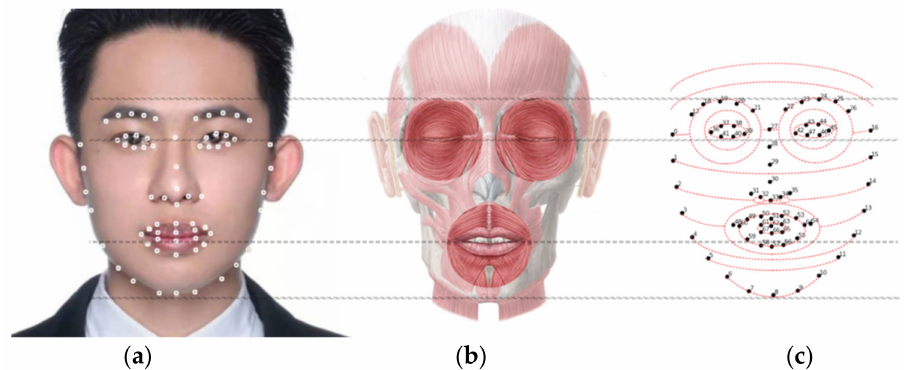
Figure 3. The curves designed to divide a canonical 3D face model into patches, ( a ) face photo with 68 landmark points, ( b ) anatomical diagram of facial muscles, ( c ) a concept sketch of face curves designed using landmark points and the anatomical diagram as references.